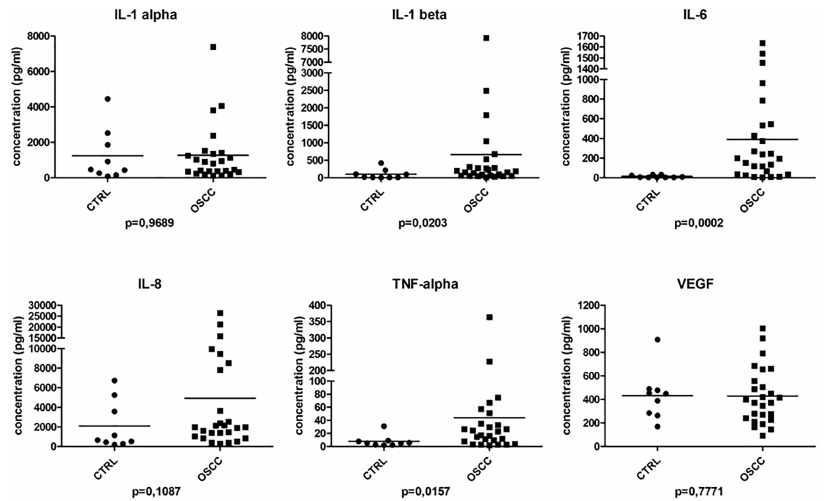
Fig 2. Salivary cytokine levels determined with Luminex-based multiplex assay. The concentration (pg/ ml) of the studied cytokines is indicatedin case of control (CTRL) and OSCC group. Below each graph the p value is